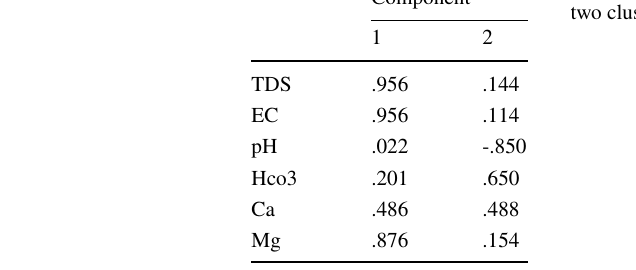
Table 6 Rotated component matrix